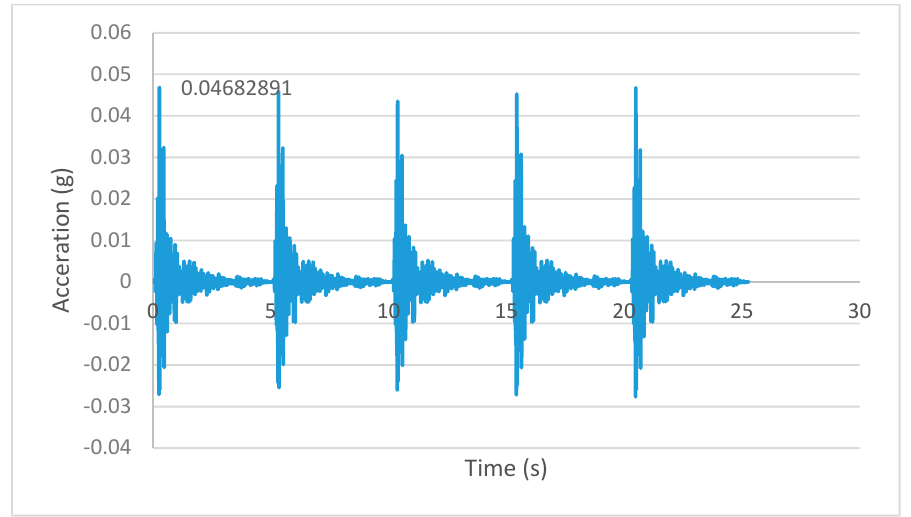
Figure 13. The accelerogram of the Friuli earthquake, Italy 1981 (Peer Ground Motion Database